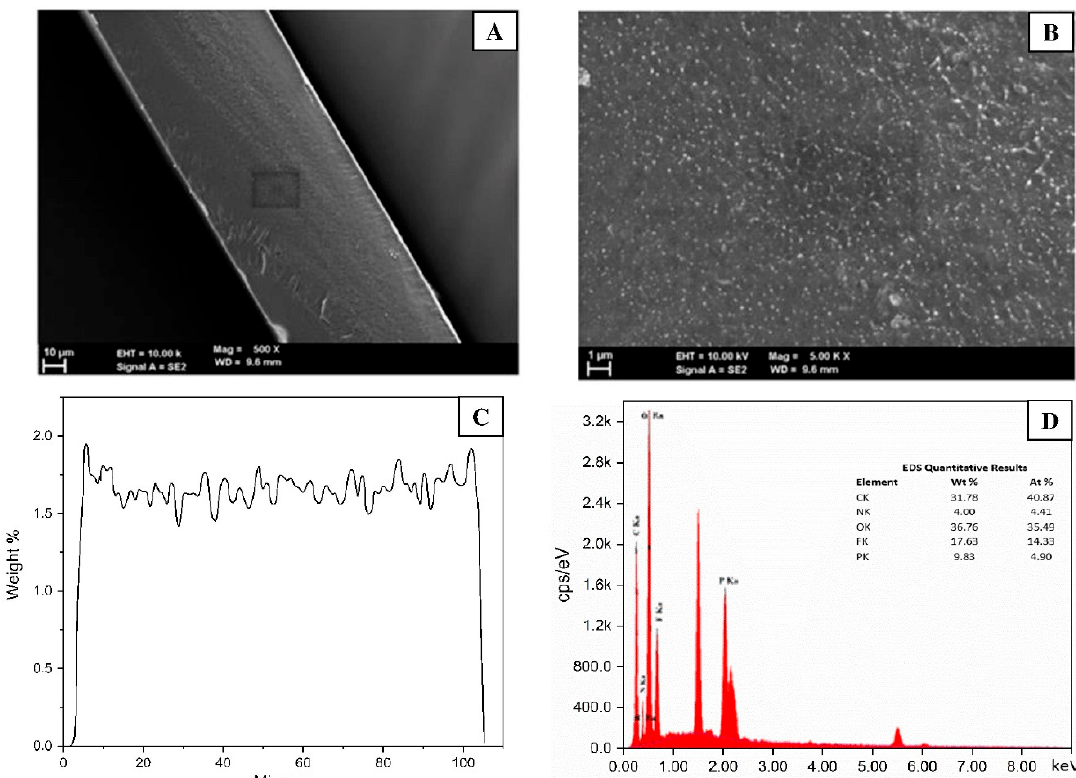
Figure 8. Cross-sectional view of ETFE- g -P(4-VP/1-VIm)/PA membrane with: ( A ) low magnification, ( B ) high magnification and ( C ) phosphorus mapping across membrane together with ( D ) EDX image of membrane elemental composition.